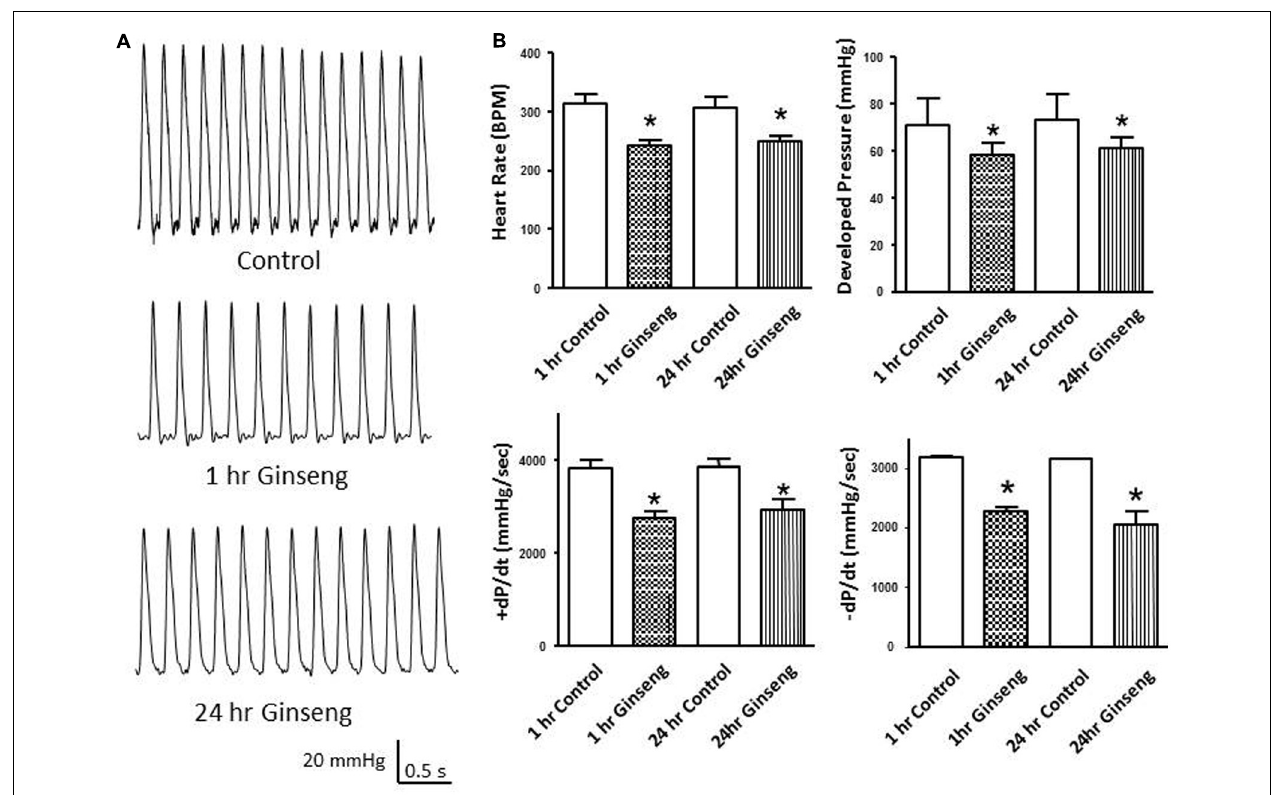
FIGURE 3 | Langendorff isolated-perfused heart data recorded from control and water-soluble ginseng extract treated rats ( n = 6/group; 1 and 24 h after gavaging). (A) Shows representative traces of developed